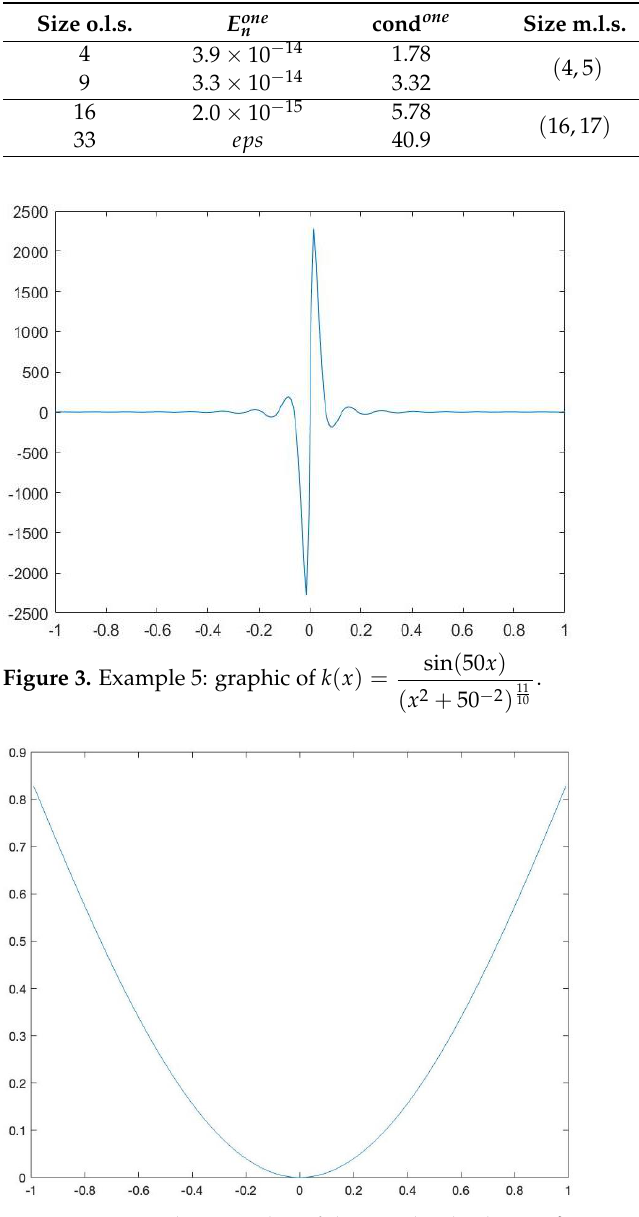
Figure 4. Example 5: graphic of the weighted solution fu